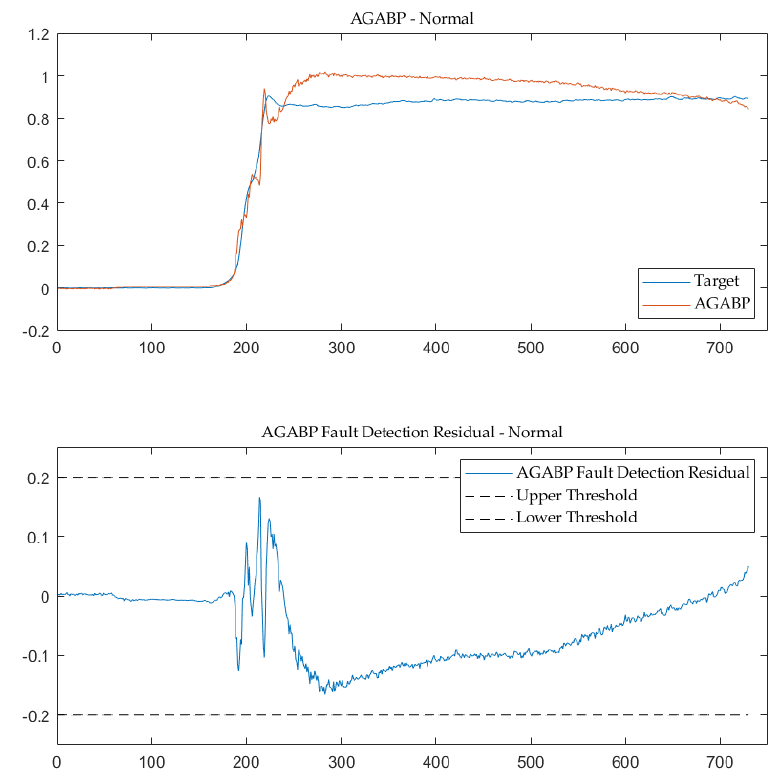
Figure 6. AGABP fault detection—normal.